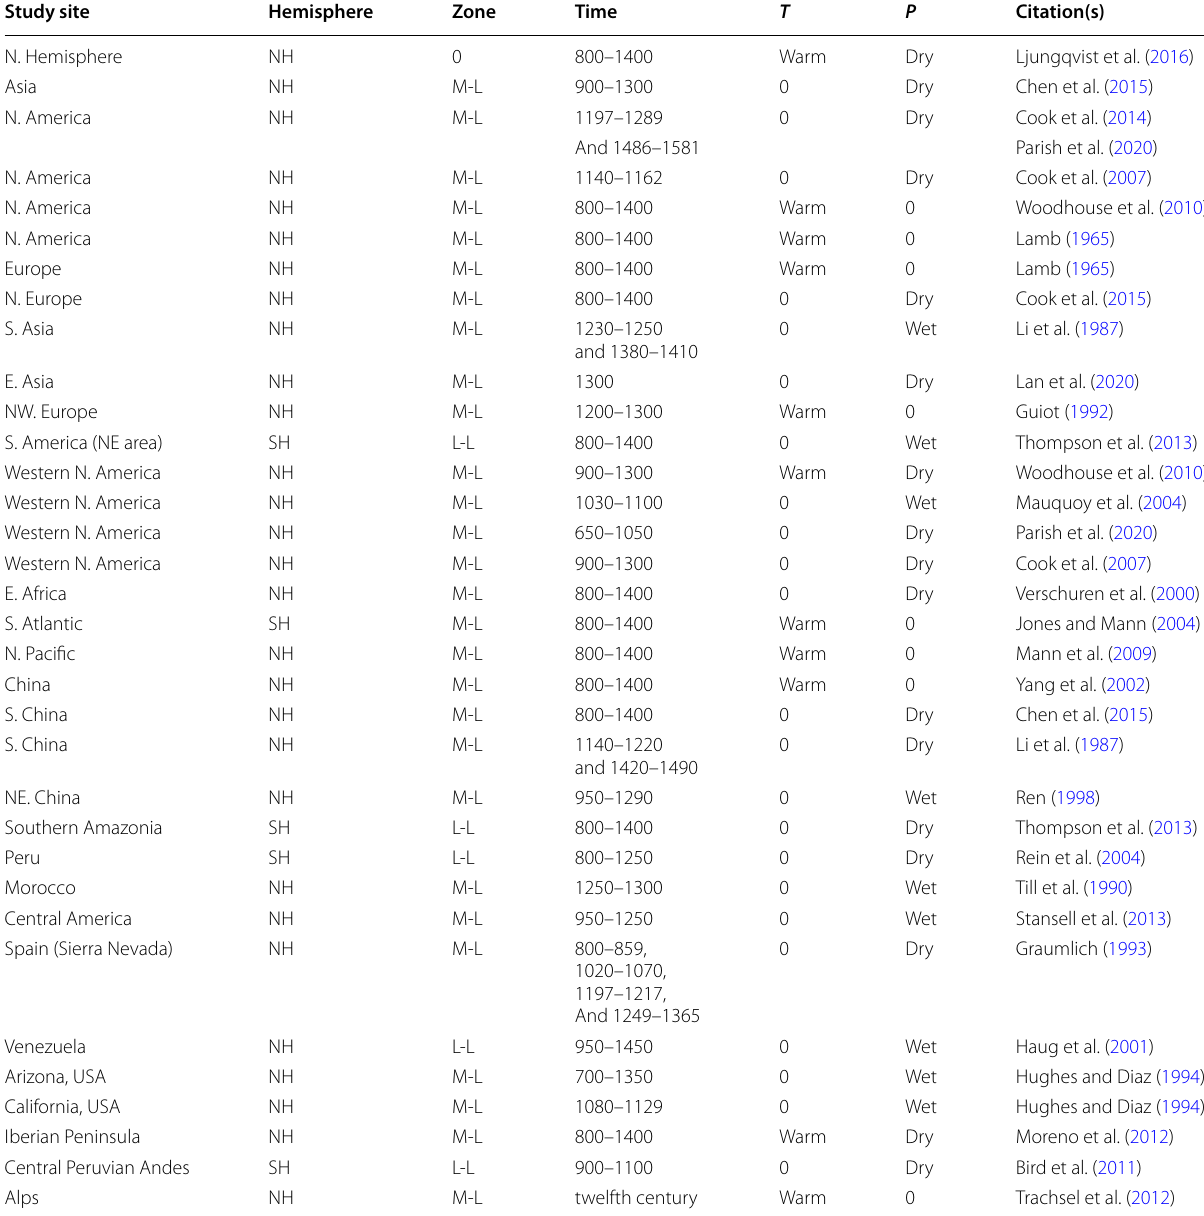
Table 8 Temperature and precipitation conditions during the